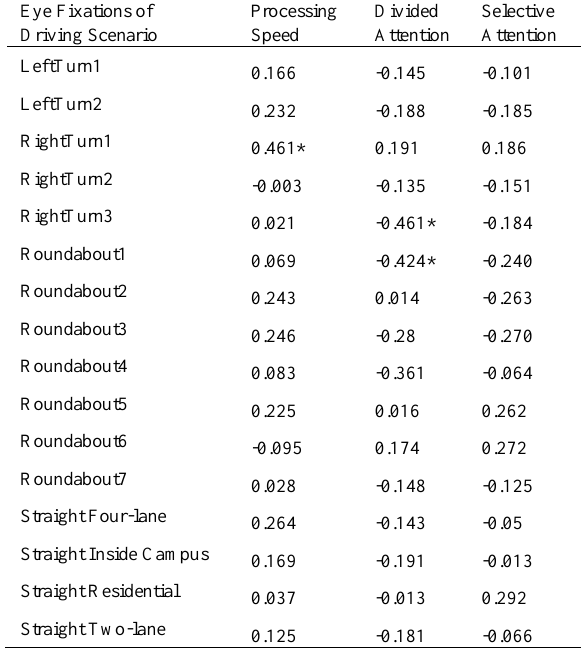
Correlation coefficients between visual capacity and mean fixa- tion duration at different driving scenarios (*p<.05; **p<.01, 2- tailed).